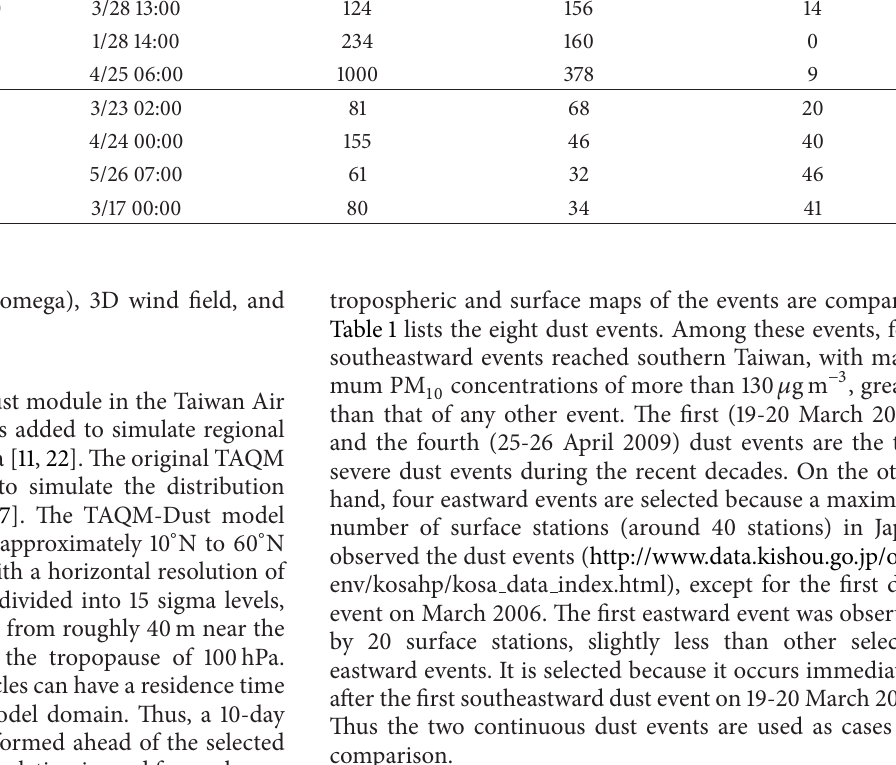
Table 1: The date of selected eastward and southeastward dust events in Taiwan and Japan respectively, their peak hour at Wanli, Taiwan, and Matsue, Japan, obtained from surface or lidar measurements, their maximum PM 10 concentration at northern (Wanli) and southern tip (Hengchun) of Taiwan, and number of Japanese stations that observed the dust events. Peak hour at Taiwan N. Type of dust event Observed date or Japan (UTC)